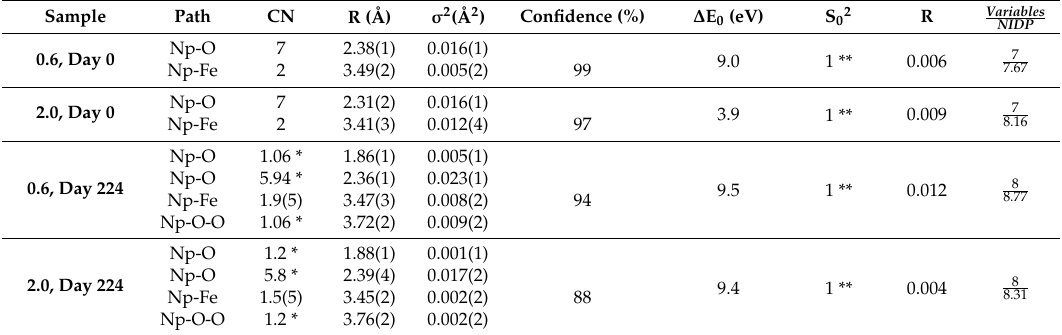
Table 2. Details of EXAFS best fit parameters for Fe(II)/Fe(III) = 0.6 (magnetite) and Fe(II)/Fe(III) = 2.0 (green rust) samples at 300 ppm neptunium before and after